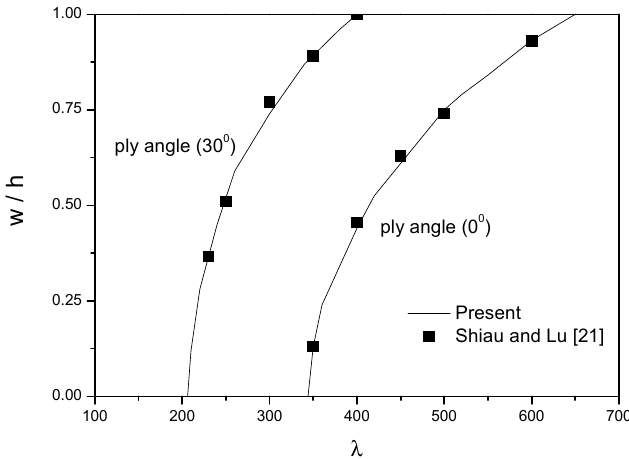
Figure 2. Natural frequencies for smart-skin antenna structure. Next, Figure 3 shows the limit-cycle oscillation (LCO) amplitudes of the model to verify the time integration process. Newmark’s method is used as 0.1 ms for the time step. Additionally, the deflection is the transverse deformation at x/a = 3/4 and y/b = 1/2 for maximum magnitude of the LCO. The numerical simulations show good agreement with the numerical data [21].